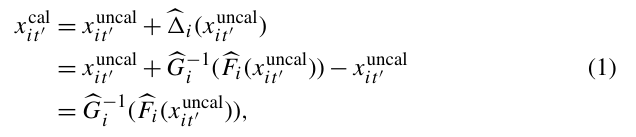
Calibration of a new value x uncal